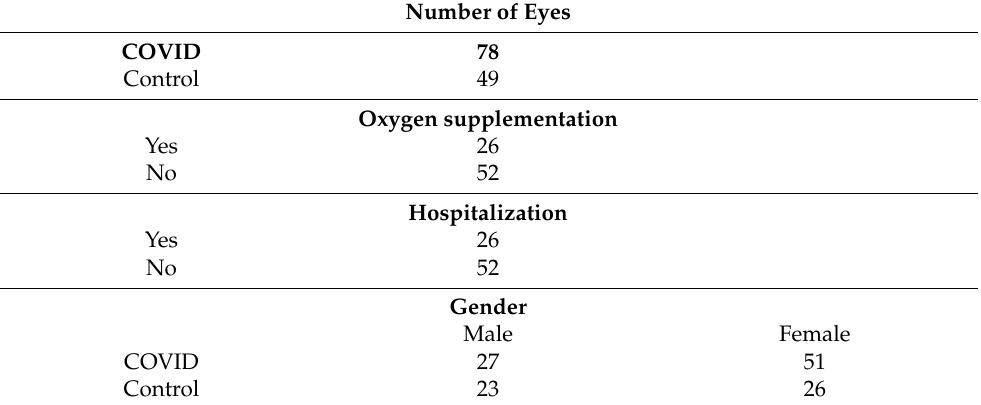
Table 1. Qualitative demographic data.